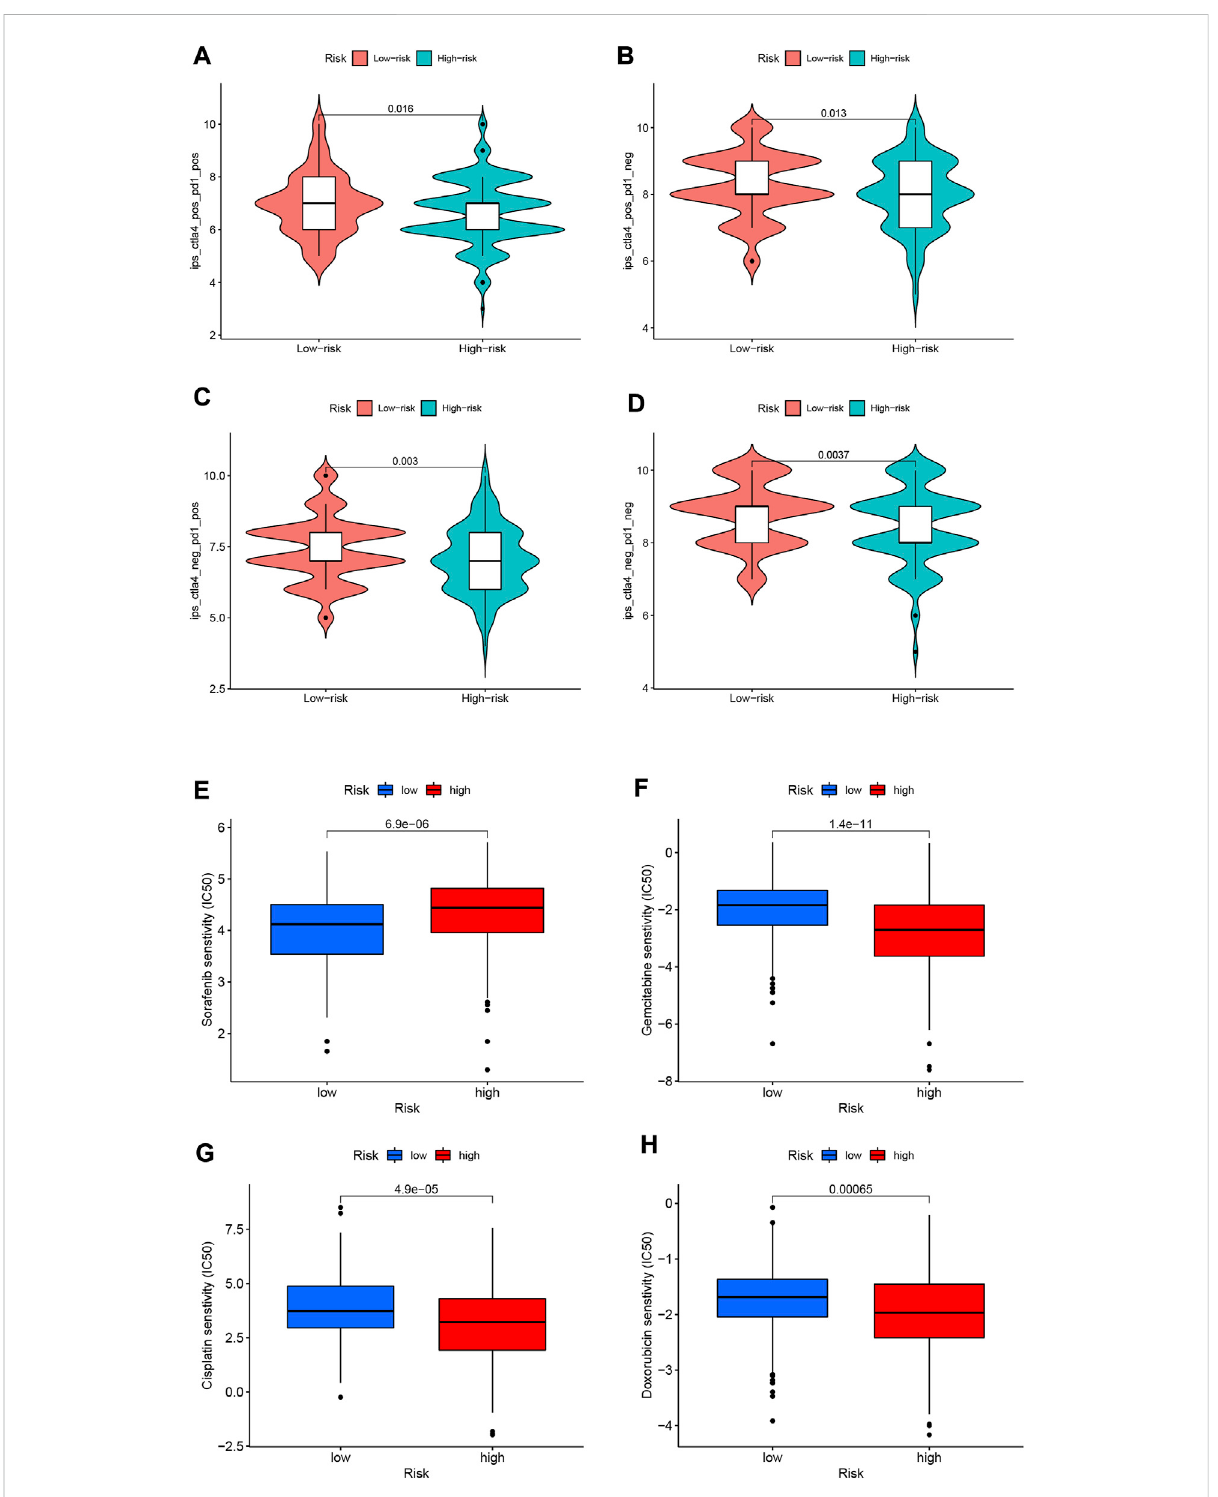
FIGURE 12 (A – D) IPS score distribution map. Estimates of chemotherapyeffect risk scores. (E) Sensitivity analysis of sorafenib inpatients with high and low risk scores. (F) Sensitivity analysis of gemcitabine in patients with high and low risk scores. (G) Sensitivity analysis of cisplatin in patients with high and low risk scores. (H) Sensitivity analysis of doxorubicin in patients with high and low risk